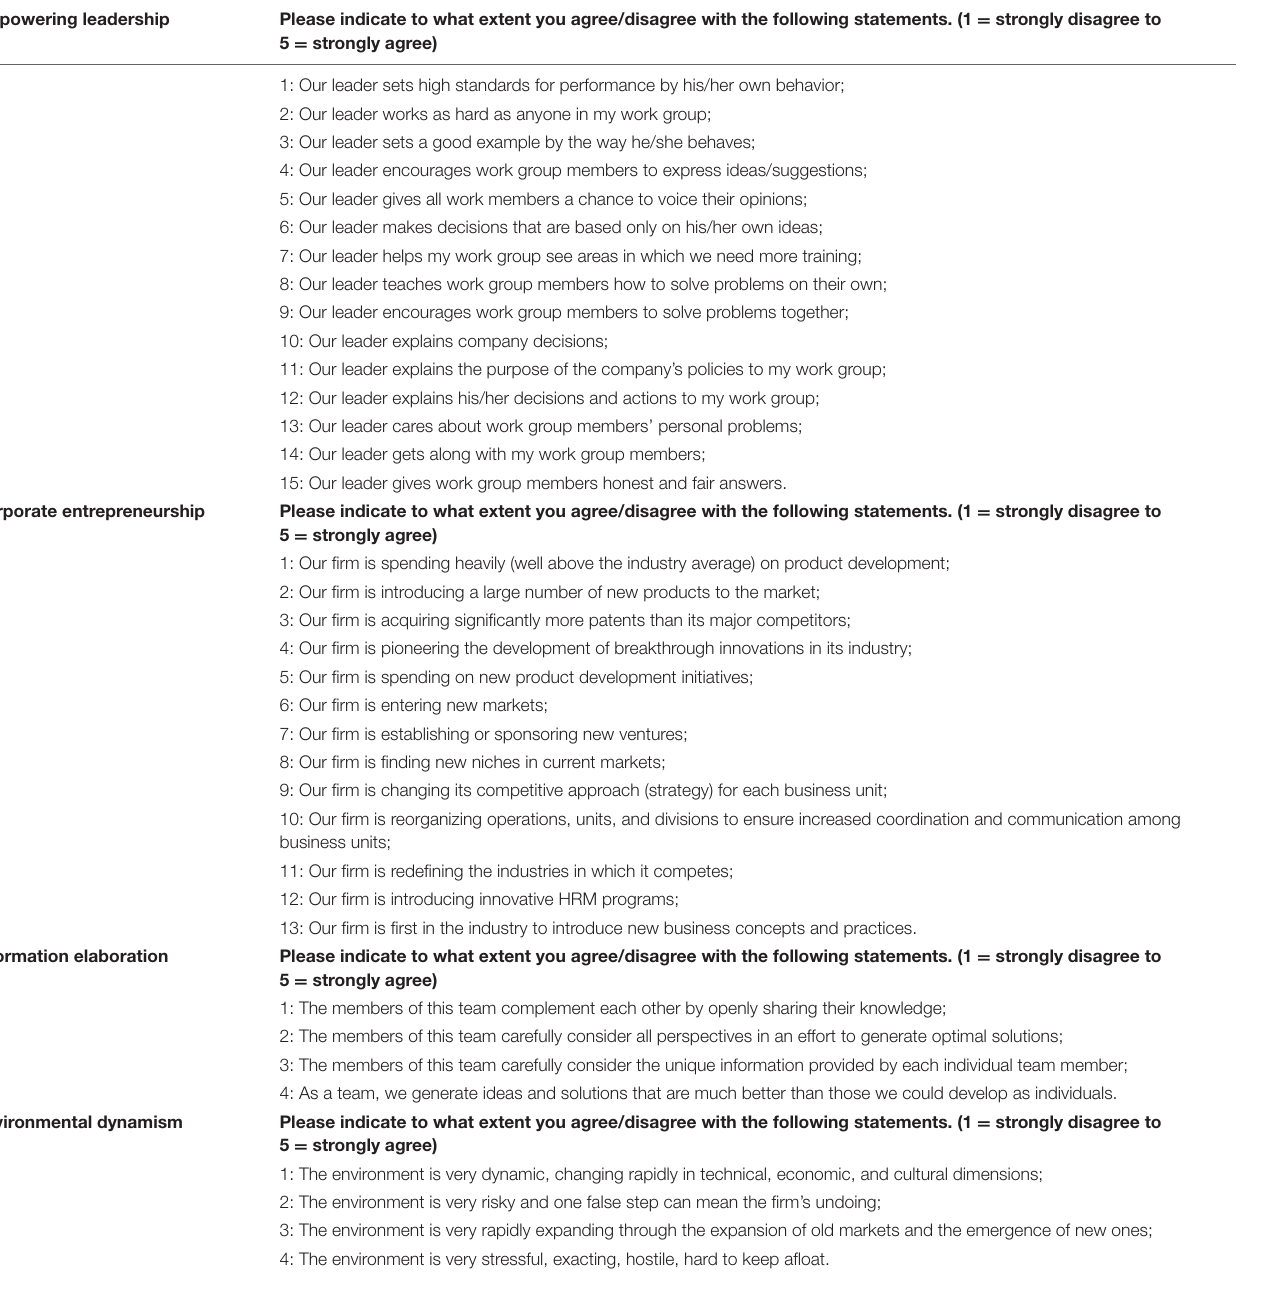
TABLE A1 | Main scales used in this